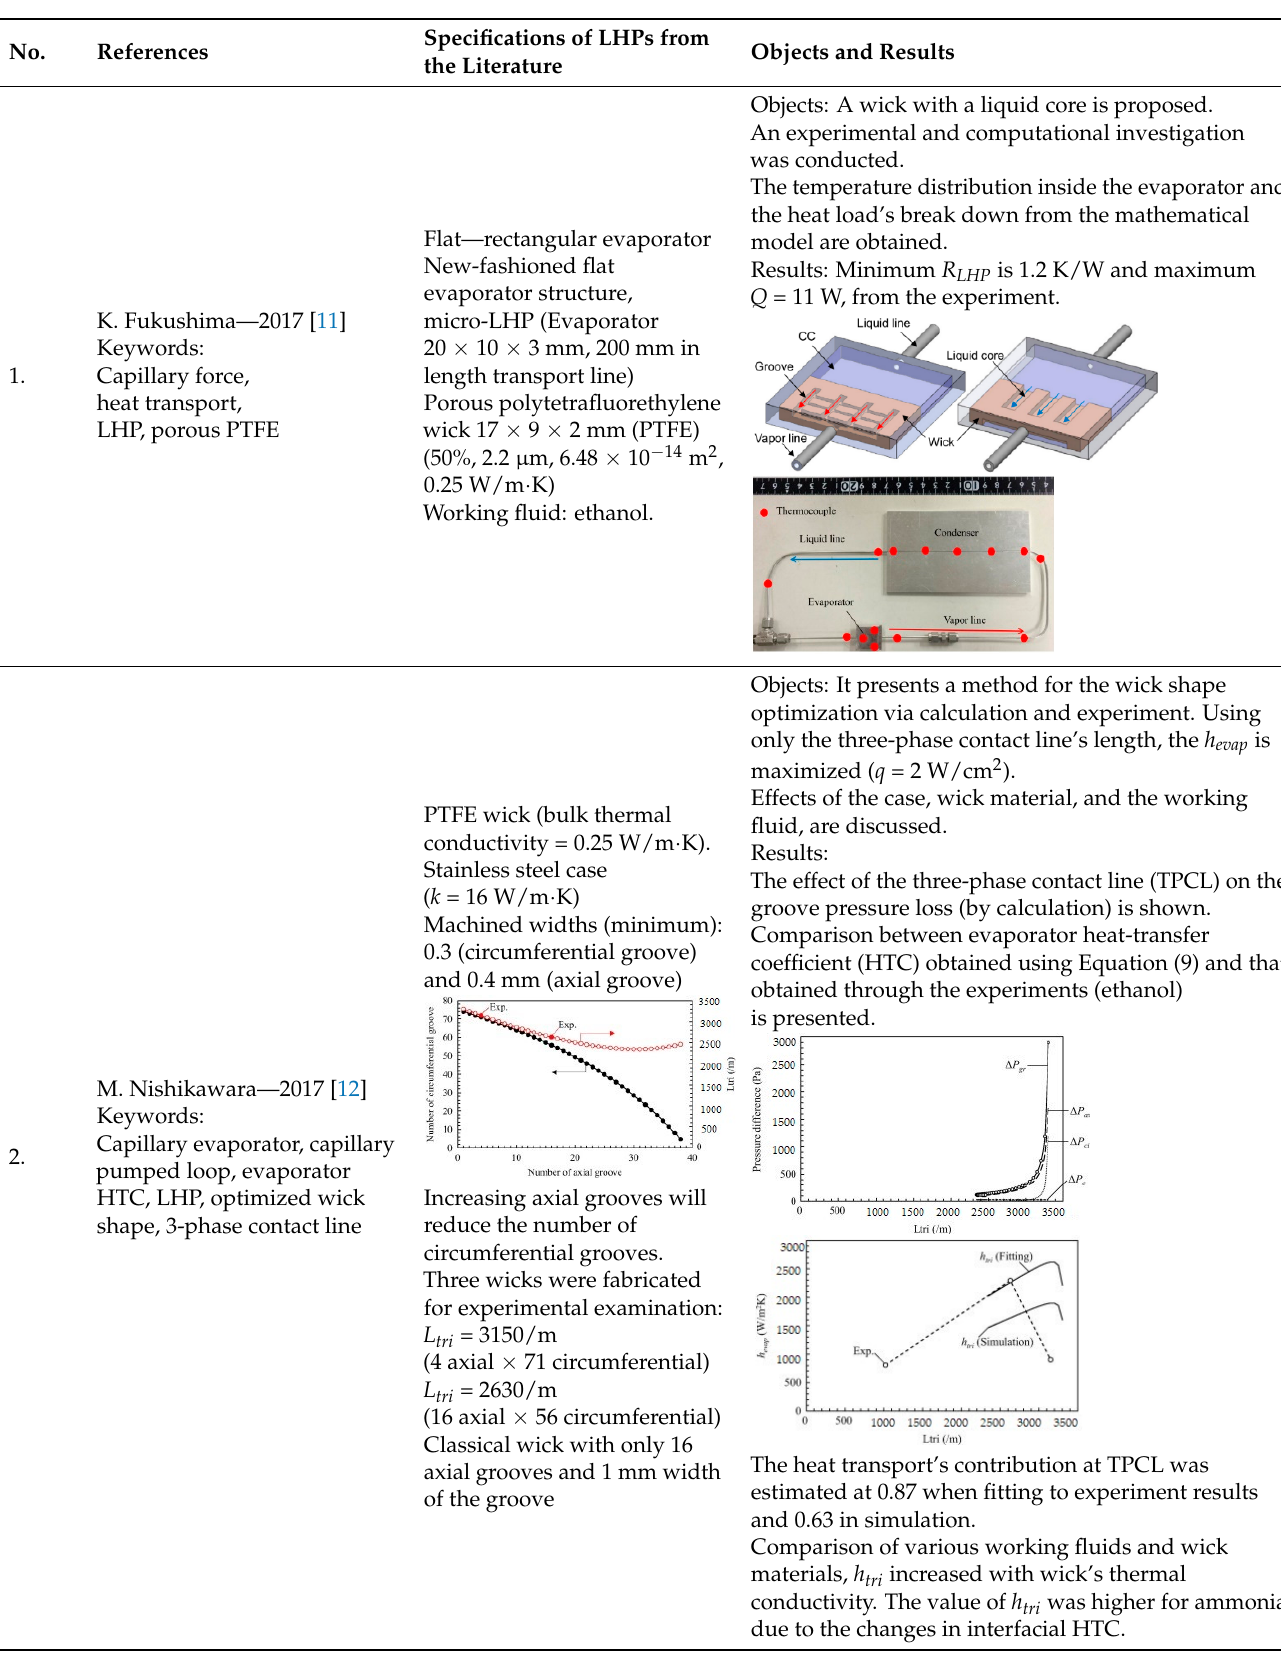
Table 2. Different LHP technologies from the